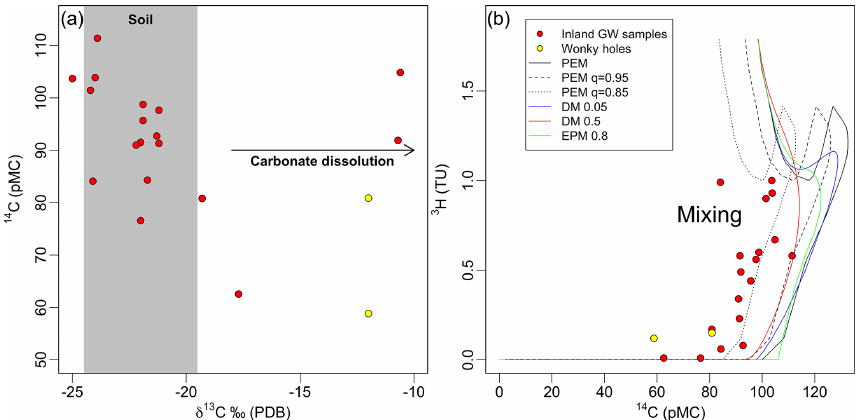
Figure 6. (a) 14 C concentration vs. δ 13 C values of groundwater and water from the wonky holes. The shaded grey area represents the predicted range of δ 13 C values of DIC in the soils. (b) 14 C concentrations vs. 3 H activities of groundwater and the water from the wonky holes. The curves show the predicted covariance from the lumped parameter models: PEM represents the partial exponential model with dilution factors of q = 0 . 95 and q = 0 . 85, DM represents the dispersion model (with dispersion parameters of 0.05 and 0.5), EPM represents the exponential piston flow model (with an EPM factor of